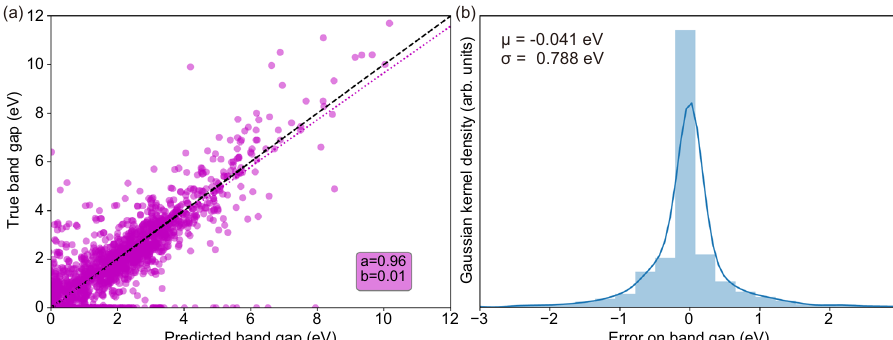
Fig. 9 Final results obtained by applying the denoising procedure to the whole dataset E. a True (i.e., experimental) vs. predicted band- gap parity plots. The corresponding plots produced by splitting the data according to the intersections with datasets P, H, S, and G are given in Fig. 1 and compared with the raw DFT data. b Corresponding error distribution plot.